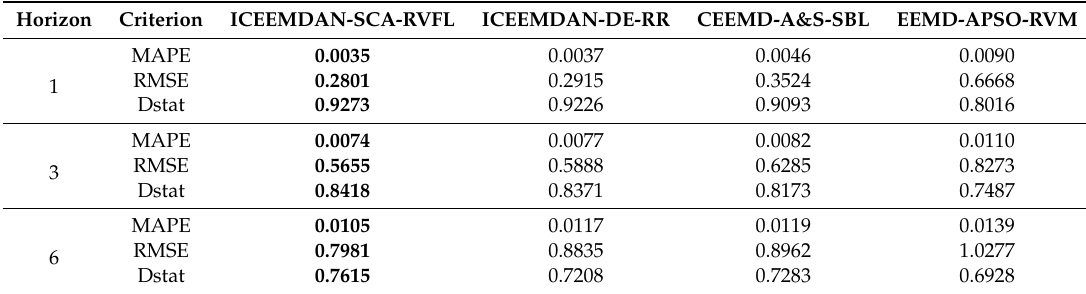
Table 6. Comparison with some extant ensemble models.